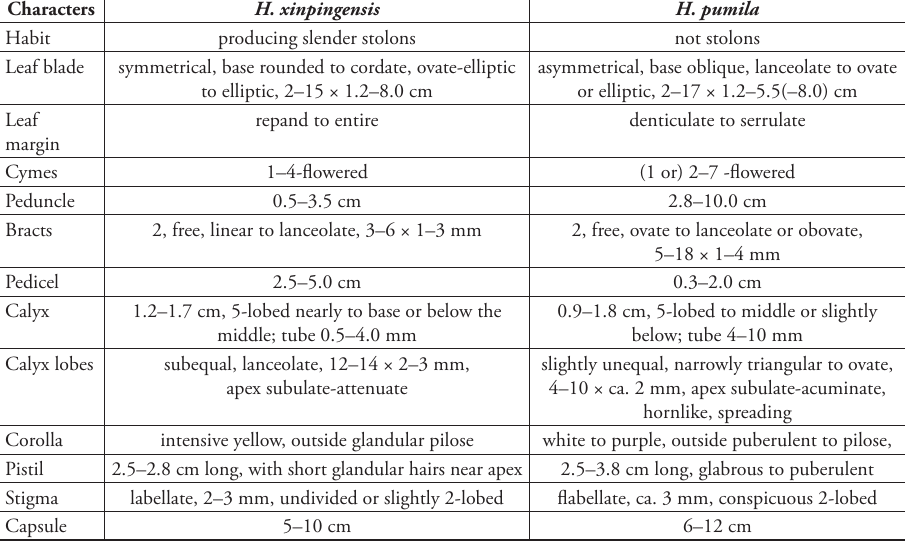
Table 4. Morphological comparison of Henckelia xinpingensis and its closely related species.